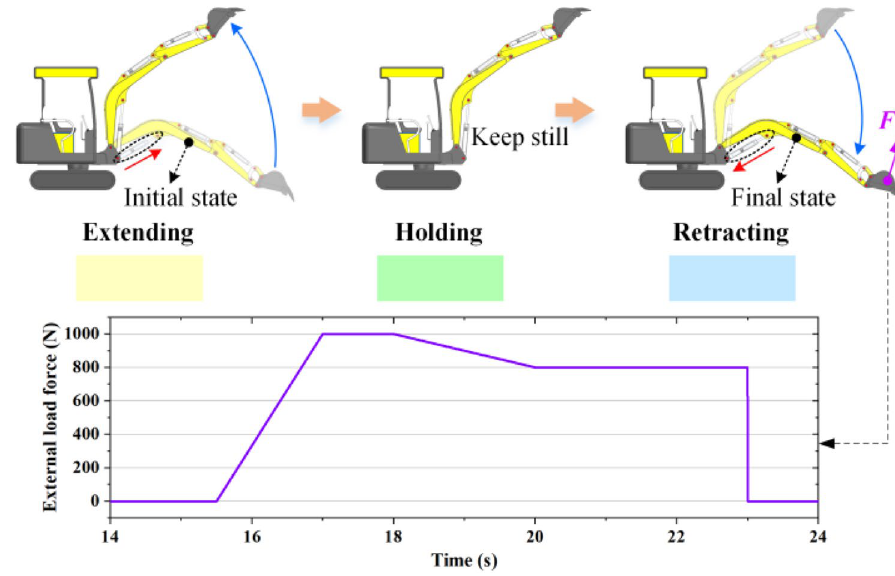
Figure 19 Schematic diagram of the boom movement with variable external load